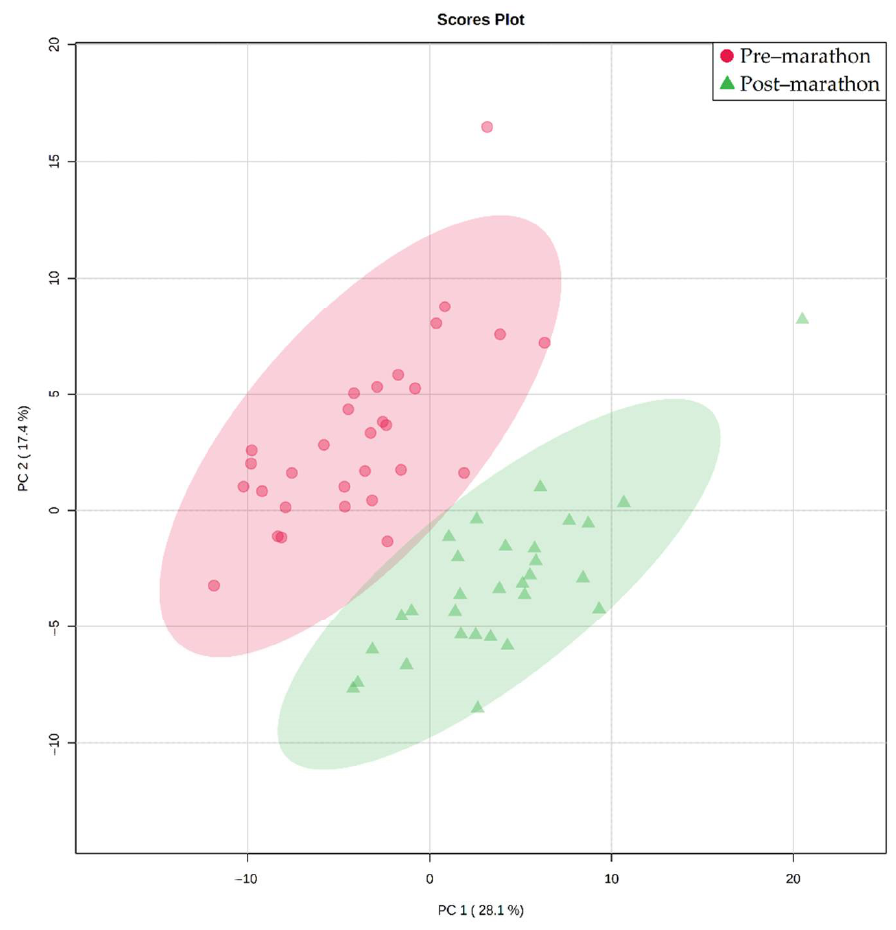
Figure 1. Principal component analysis (PCA) plot illustrating the natural differentiation of the pre-marathon (red circles) and post-marathon (green triangles) serum metabolic profiles of the 30 marathon participants. Table 1. Statistically significant marathon-induced metabolite changes.